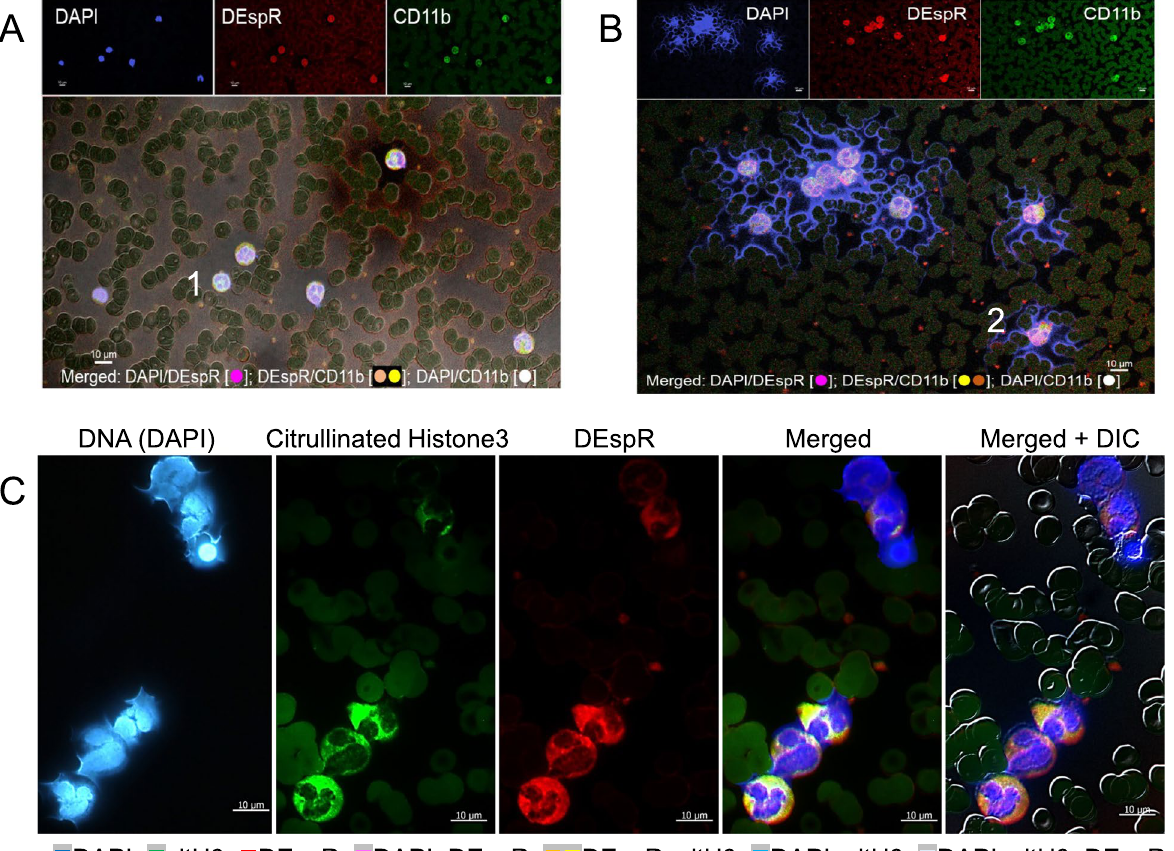
Fig. 1 Representative images of differential levels of circulating NET Ns by immunofluorescence‑cytology (IFC). A ‑ B Representative IFC confocal + microscopy image [z‑stack through nucleus] showing minimal to no DEspR CD11b [NET Ns] with extruded DNA (blue) in a (A) COVID‑19 + + + survivor, and (B) increased DEspR [NET Ns] in COVID‑19 non‑survivor. Bar 10 μm; DEspR CD11b microvesicles observed < 1 μm. Panel A #1 + + + + and Panel B #2: neutrophils shown in Fig. 2‑A. C Representative IFC images of DEspR [NET Ns] showing from left to right: DAPI‑DNA staining + + of decondensing nuclei in various stages of extrusion of DAPI‑stained DNA, citrullinated histone‑3 (citH3) expression with varying intensities, neutrophil DEspR expression, merged image, and merged image with differential interference contrast (DIC) superimposed. Bar 10 + =